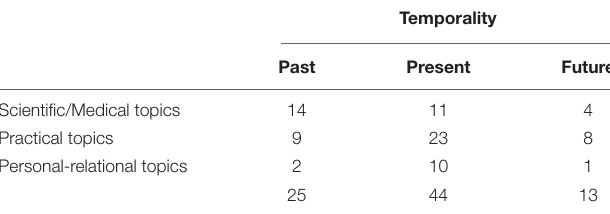
TABLE 4 | Frequency of functions by the different “non lo so” topics. Function